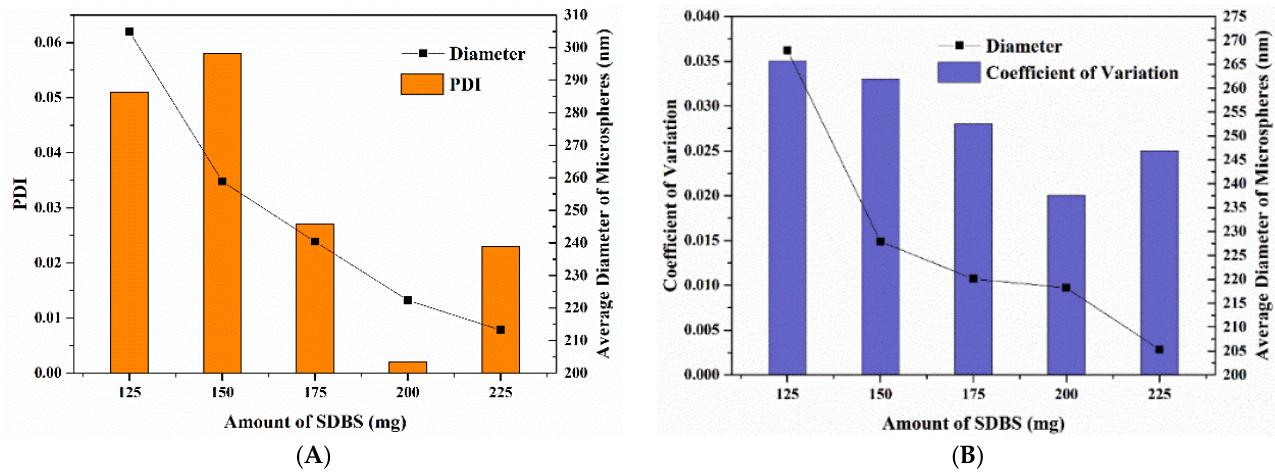
Figure 7. Particle size analysis of P(St-AA) colloidal microspheres synthesized with different amounts of SDBS: ( A ) by DLS characterization; ( B ) by measuring FE-SEM images. All colloidal microspheres in the FE-SEM images were orderly arranged during drying, and only point and line defects existed in each sample without disordered arrangement (Figure 8). This may be caused by steric hindrance between the ordered photonic crystals. The variation in the average diameter of P(St-AA) microspheres synthesized with different amounts of SDBS was consistent with the DLS results (Figure 7B).